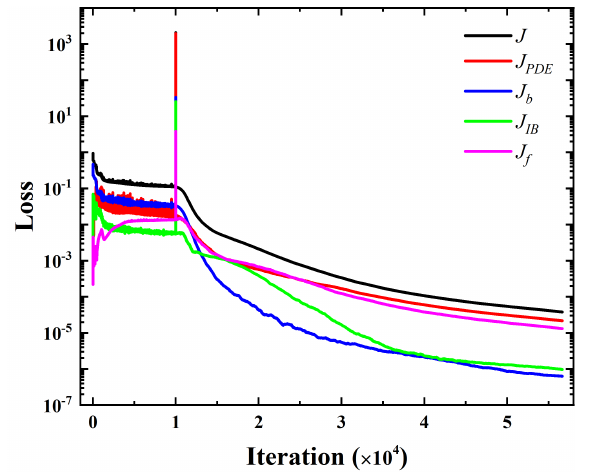
Figure 4. Convergence of loss function. The DNN of 6 × 100 is used. The number of collocation points is 72,365. The weights for the loss components are: λ = 1.0; α = 2.0; β = 2.0; γ = 1.0.